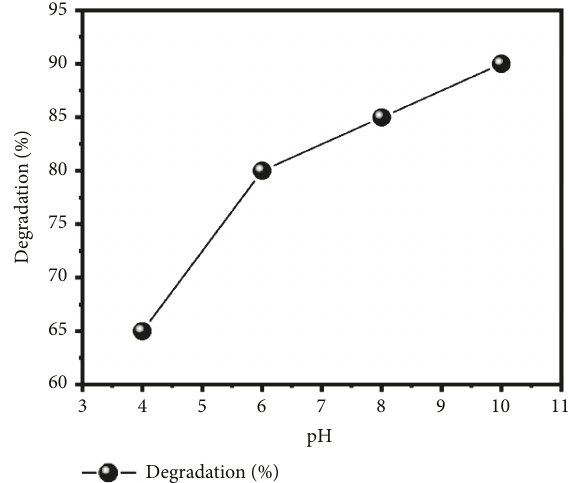
Figure 10: Effect of pH on methylene blue